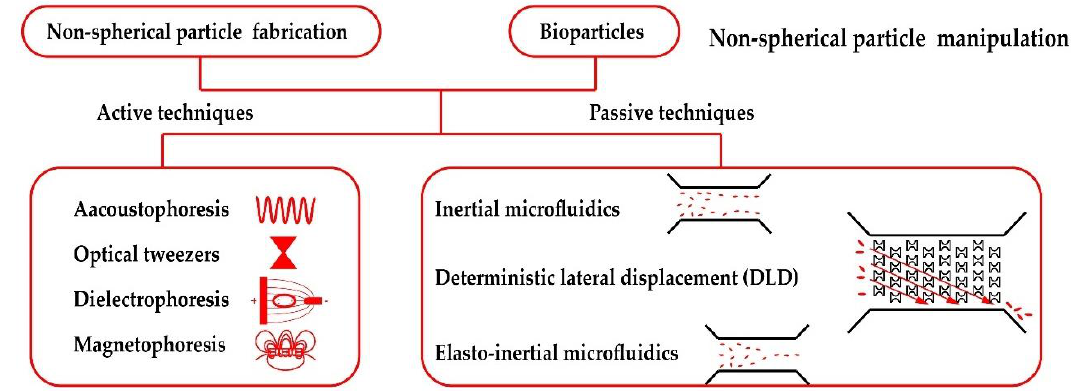
Figure 1. Non-spherical particle manipulation techniques.